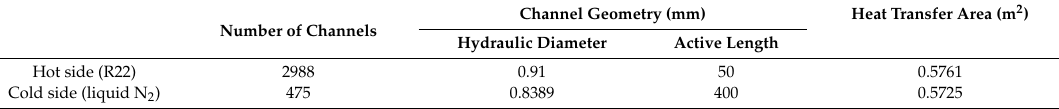
Table 1. Printed Circuit Heat Exchanger (PCHE) channel